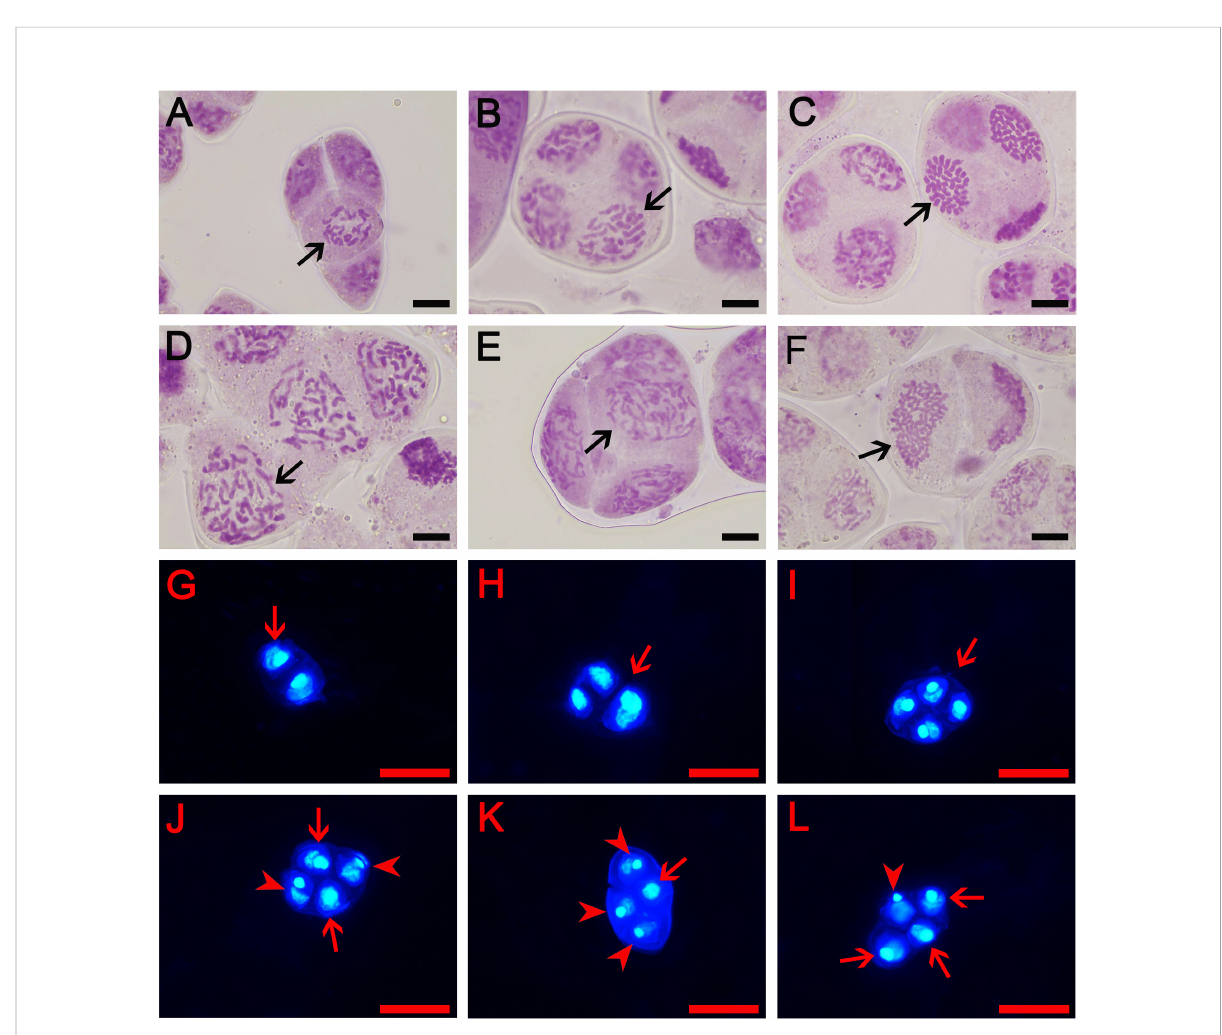
FIGURE 2 Types of male gametes in diploid and triploid cymbidiums. (A – F) represent early microspore stage where (A) The aneuploidy gamete of ‘ Xiaofeng ’ : x -2 = 18 (arrow) and (B – F) The gamete of ‘ Yuchan ’ : (B) 1 x gamete: x = 20 (arrow), (C) Aneuploidy gamete: x +10 = 30 (arrow), (D) 2 x gamete: 2 x = 40 (arrow), (E) Aneuploidy gamete: 2 x +2 = 42 (arrow), and (F) Unreduced gamete: 3 x = 60 (arrow). Bar = 10 m m. Additionally, (G – L) represent mature pollens stained with 4, 6-diamidino-2-phenylindole (DAPI): (G) Dyad (arrow), (H) Triad (arrow), (I) Tetrad with the same size of nuclei (arrow), (J) Tetrad with two large (arrow) and two small nuclei (arrowhead), (K) Tetrad with one large (arrow) and three small nuclei (arrowhead), and (L) Tetrad with three large (arrow) and one small nuclei (arrowhead). Bar = 50